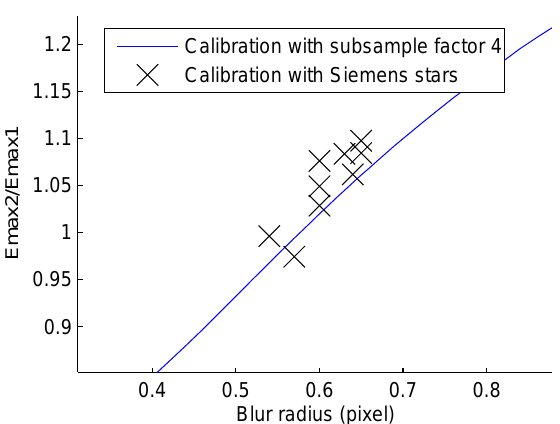
Figure 7: Comparison with blur estimation using Siemens stars: black crosses are at coordinate ( σ Siemens , r ) where σ Siemens is the blur estimation with Siemens stars, and r = ¯ E max 2 / ¯ E max 1 is read at the Siemens star center using our approach. The dif- ference between blur estimation using the two approaches is given by horizontal distance from crosses to the calibration curve (blue).